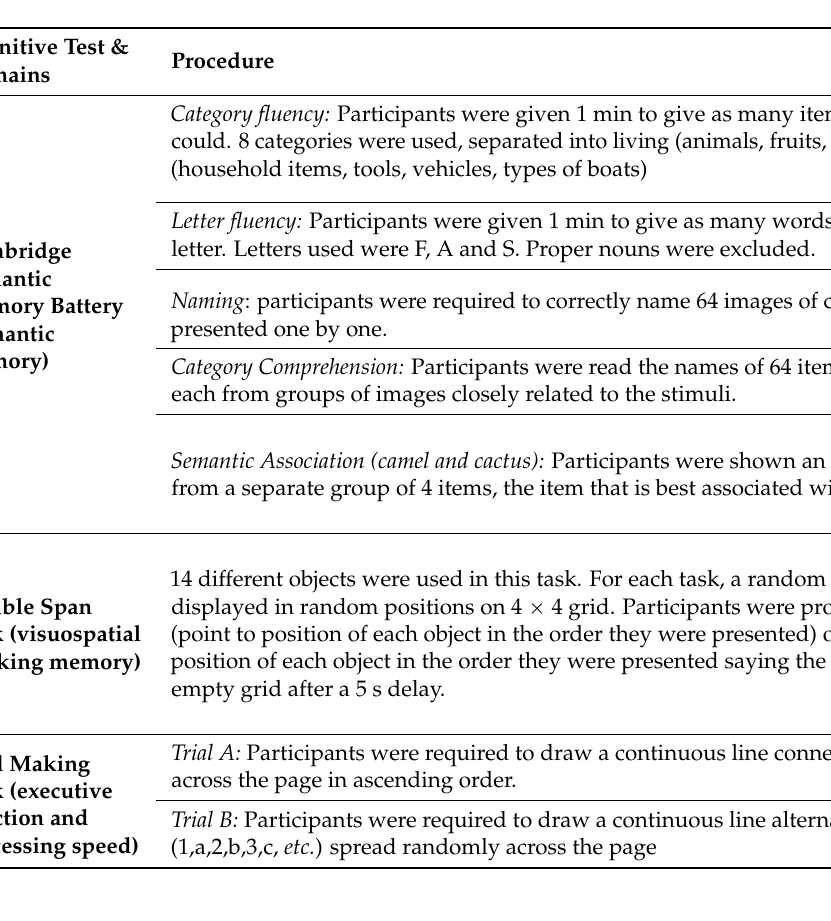
Table 2. Components of the Neuropsychological test